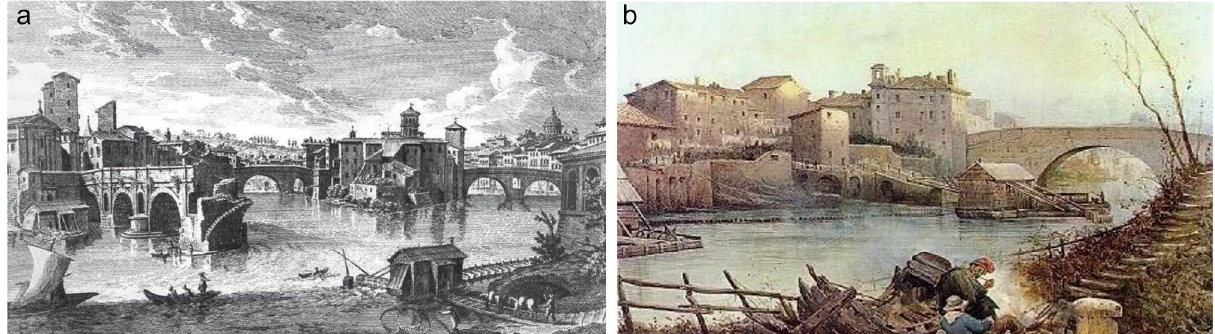
Figure 1. The Tiber River near the city of Rome as a source of danger as well as wealth. ( a ) Engraving by Giuseppe Vasi (1710–1782) illustrating Ponte Senatorio oggi detto Ponte Rotto (1748), almost completely destroyed during the flood of 1598 (https:// www. nga. gov/ colle ction/ art- object- page. 125672. html; image available free of charge for any use, commercial or non-commercial under Creative Commons Zero Open under Access Policy for Images of Works of Art Presumed in the Public Domain, National Gallery of Art, Washington DC, USA, https:// www. nga. gov/ notic es/ open- access- policy. html); ( b ) Painting of Ponte Cestio ed Isola Tiberina (rione Ripa) with the mills of SS. Annunziata and S. Francesco by Ettore Roesler Franz (1845–1907), c. 1880 (https:// en.m. wikip edia. org/ wiki/ File: Isola Tiber inaEP onteC estio ByRoe slerF ranz. jpg; work in the public domain, content available under CC BY-SA